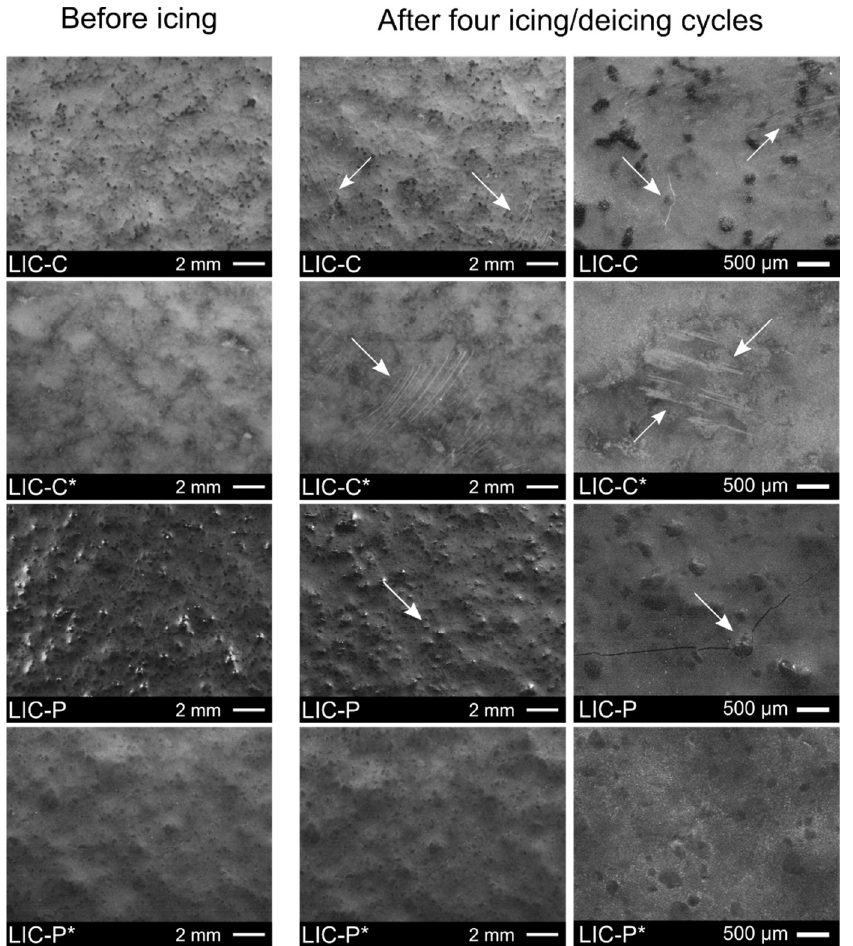
Figure 8. Surface morphologies of lubricated icephobic coatings (LICs) before and after four ic- ing/deicing cycles at different magnification. C and P refer to fully hydrogenated cottonseed oil and paraffinic wax additives, respectively. The asterisk indicates the post-heating treatment by flame. White arrows indicate the presence of surface defects produced during the cyclic tests.